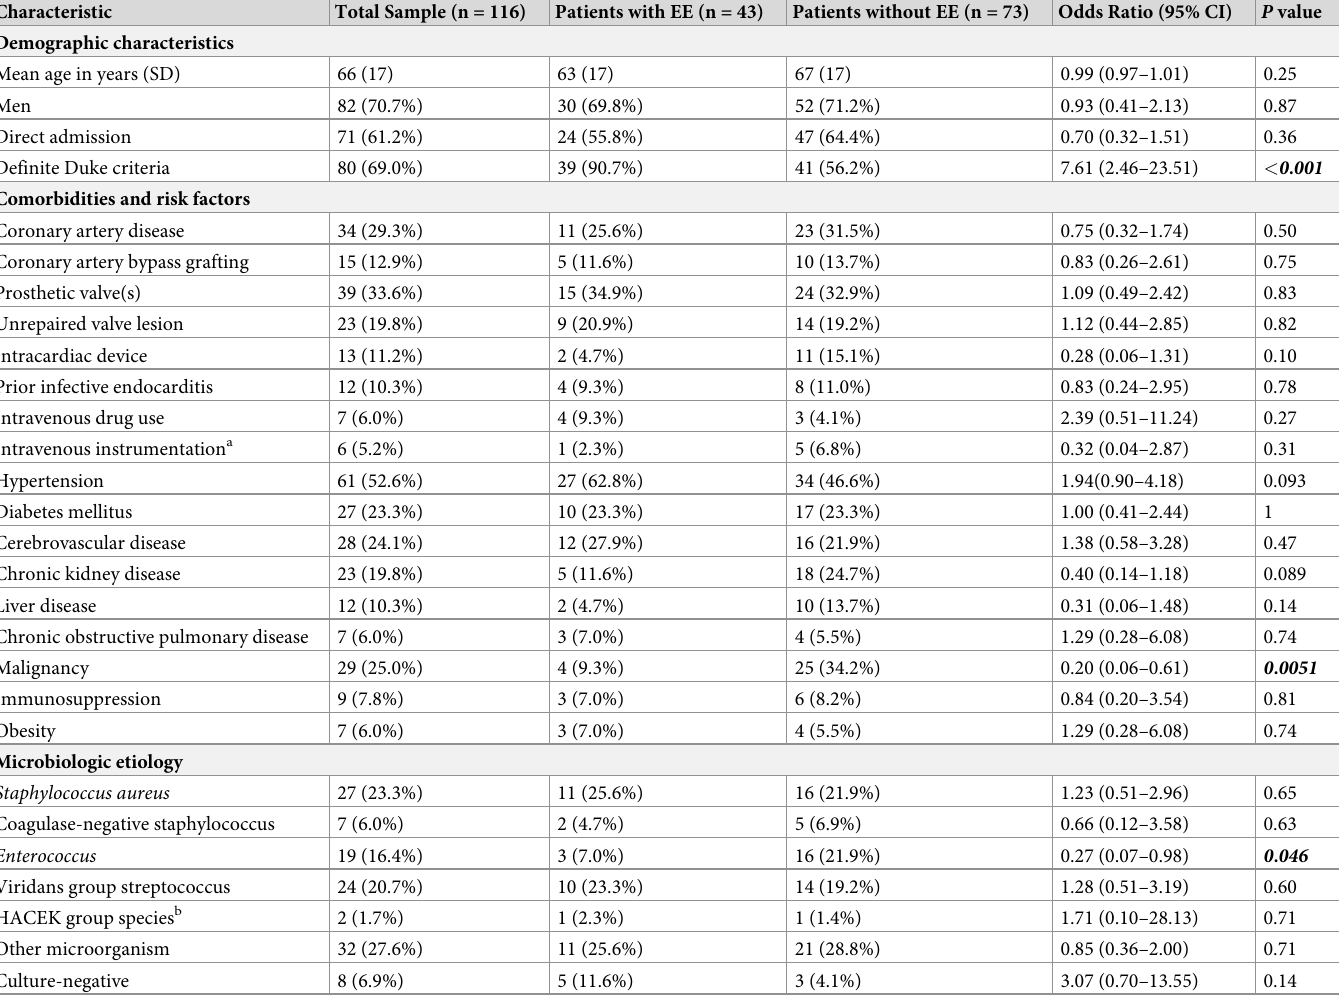
Table 1. Patient and pathogen characteristics of patients with or without an embolic event at any